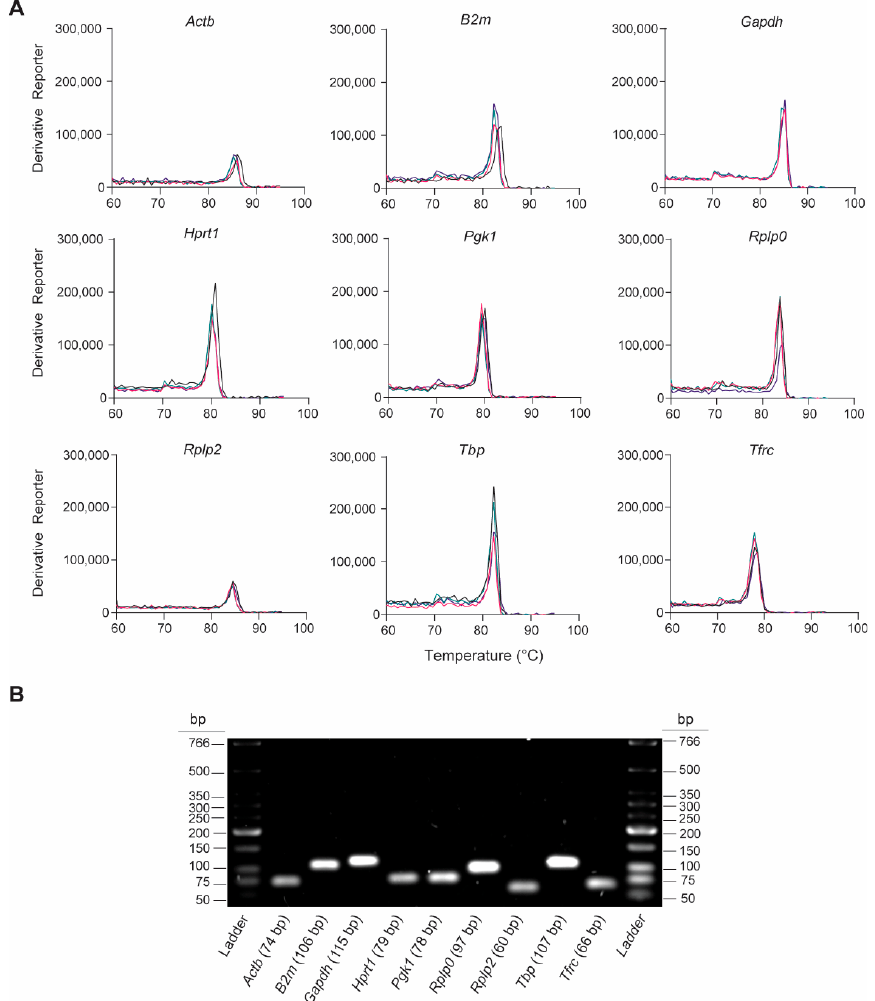
Figure 2. Validation of RT-qPCR primer specificity for the nine candidate rat-specific HKGs. ( A ) Representative melting curves obtained from qPCRs reactions, which show the peak of DNA dissociation for each HKG in lung tissue 6 h post-injury; n = 4 individual melting curves. ( B ) Representative image of a 2% agarose gel electrophoresis containing PCR amplicon products (7.5 µ L/lane) obtained after